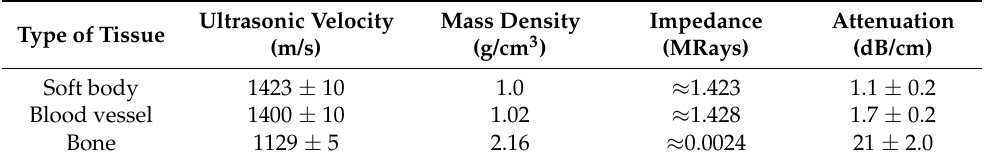
Figure 1. The newborn arm phantom (True Phantom Solutions, Windsor, CA, USA). Table 1. Mean properties of materials constituting the newborn arm phantom (True Phantom Solutions, Windsor, CA, USA) measured at 2.25 MHz and 1 MHz.